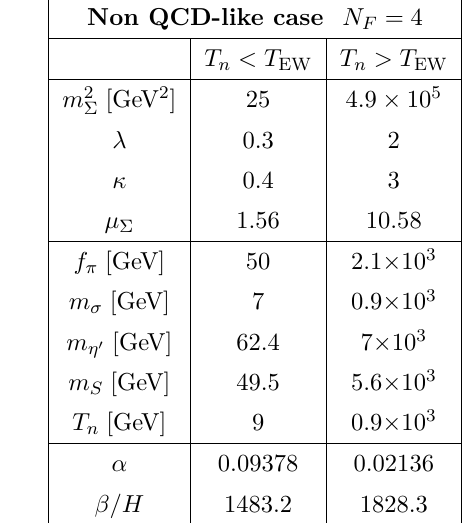
= 3 and N = 4 for the non QCD-like cases. F F